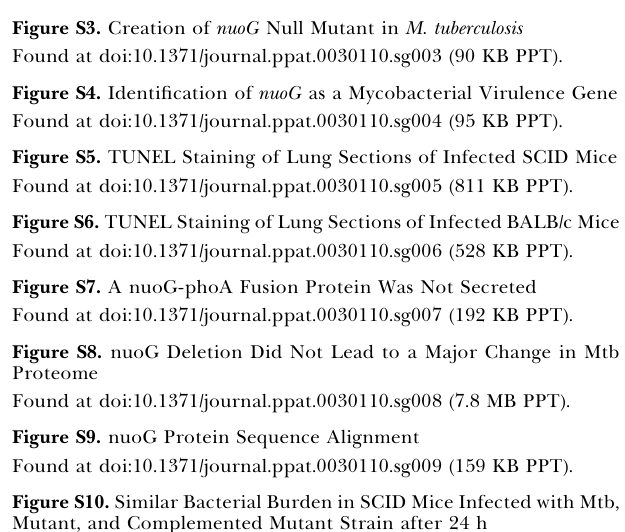
Figure S3. Creation of nuoG Null Mutant in M. tuberculosis Found at doi:10.1371/journal.ppat.0030110.sg003 (90 KB PPT). Figure S4. Identification of nuoG as a Mycobacterial Virulence Gene Found at doi:10.1371/journal.ppat.0030110.sg004 (95 KB PPT). Figure S5. TUNEL Staining of Lung Sections of Infected SCID Mice Found at doi:10.1371/journal.ppat.0030110.sg005 (811 KB PPT). Figure S6. TUNEL Staining of Lung Sections of Infected BALB/c Mice Found at doi:10.1371/journal.ppat.0030110.sg006 (528 KB PPT). Figure S7. A nuoG-phoA Fusion Protein Was Not Secreted Found at doi:10.1371/journal.ppat.0030110.sg007 (192 KB PPT). Figure S8. nuoG Deletion Did Not Lead to a Major Change in Mtb Proteome Found at doi:10.1371/journal.ppat.0030110.sg008 (7.8 MB PPT). Figure S9. nuoG Protein Sequence Alignment Found at doi:10.1371/journal.ppat.0030110.sg009 (159 KB PPT). Figure S10. Similar Bacterial Burden in SCID Mice Infected with Mtb, Mutant, and Complemented Mutant Strain after 24